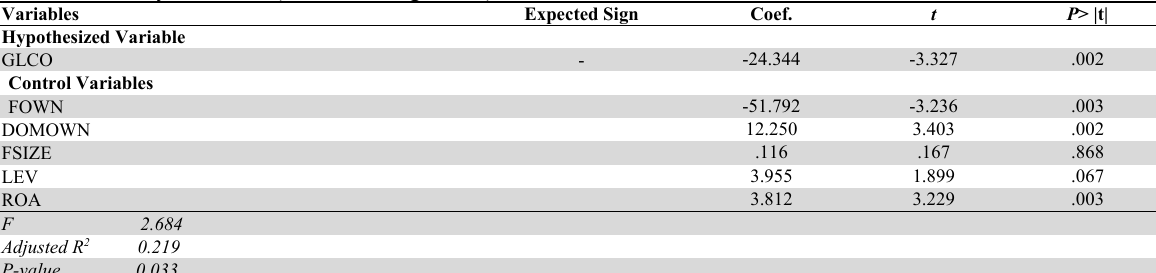
Pooled OLS Analysis Results (Board meeting model) Variables Expected Sign